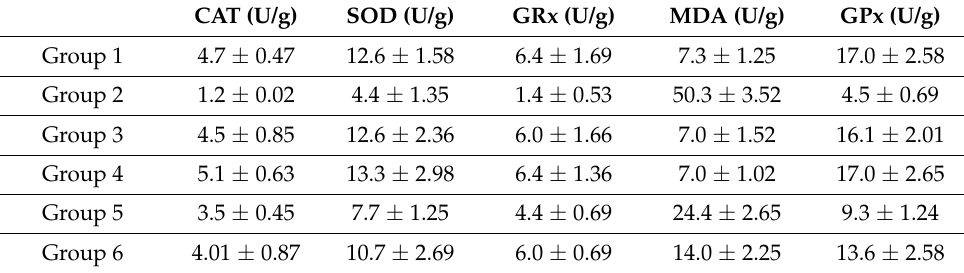
Table 4. Oxidative stress biomarkers in the brain tissue